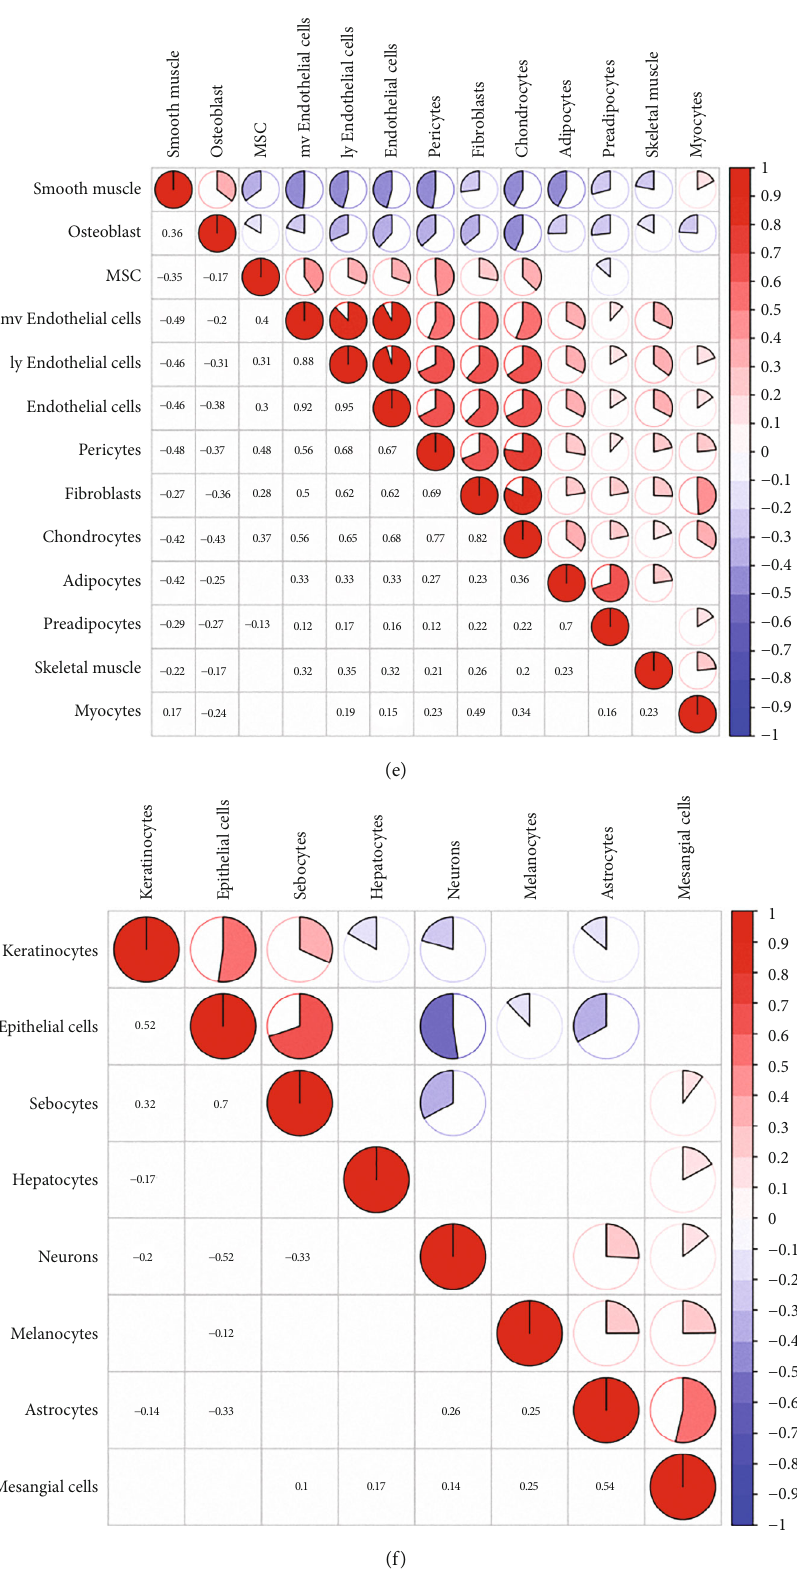
Figure 3: Correlations among the 64 types of cells. (a) Pie plot showed the correlations among the 64 types of cells. (b) Pie plot showed the correlations of cells in lymphoid cell groups. (c) Pie plot showed the correlations of cells in myeloid cell groups. (d) Pie plot showed the correlations of cells in stem cell groups. (e) Pie plot showed the correlations of cells in stromal cell groups. (f) Pie plot showed the correlations of cells in other cell